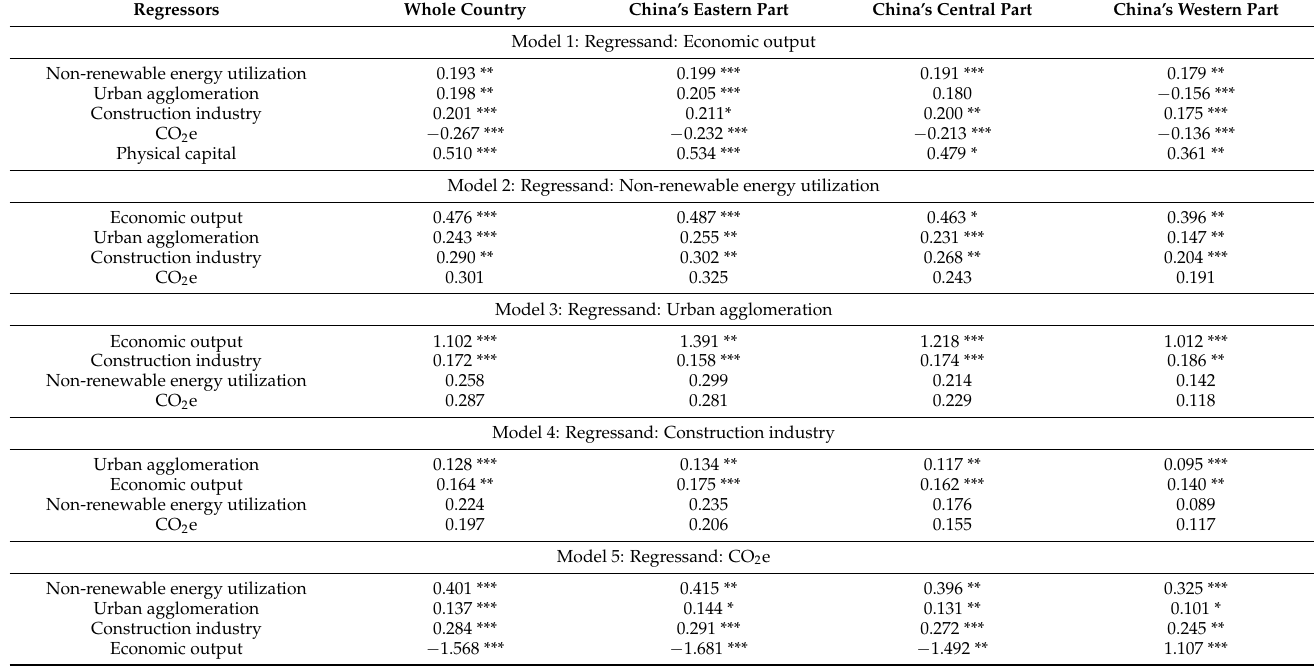
Table 5. Analytical findings for the long run based on the heterogeneous FMOLS